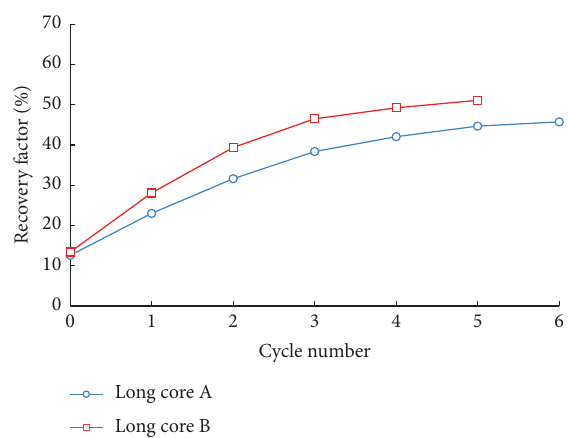
Figure 6: The difference between the cumulative oil recovery factors of long core A and long core B at each huff-and-puff cycle.